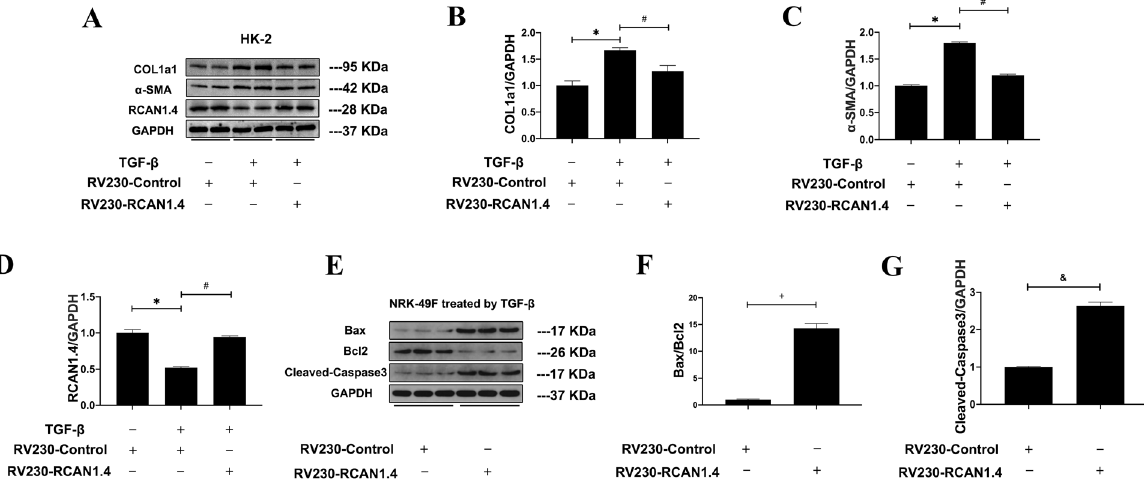
Fig. 4 Affection of overexpression of RCAN1.4 in HK-2 cells and NRK-49F cells. A Representative blots of RCAN1.4, COL1a1, α -SMA, and GAPDH; B COL1a1/GAPDH ratio; C α -SMA/GAPDH ratio; D RCAN1.4/GAPDH ratio; E Representative blots of Bax, Bcl-2, cleaved-caspase3, and GAPDH; F Bax/Bcl-2 ratio; G cleaved-caspase3/GAPDH; * p < 0.05, # p < 0.05, + p < 0.01, & p < 0.01, as indicated. The results are expressed as the mean ± standard error of the mean (S.E.M.). for 3 – 4 independent experiments.